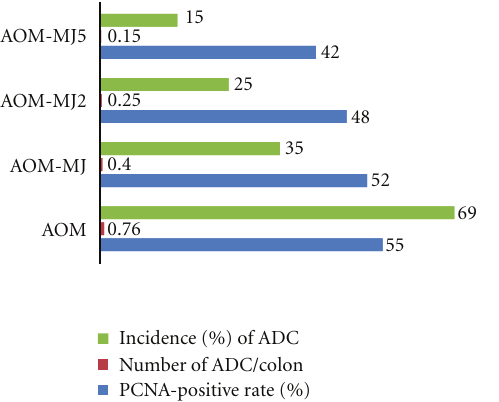
Figure 6: MJs inhibit NNK-induced lung tumors in